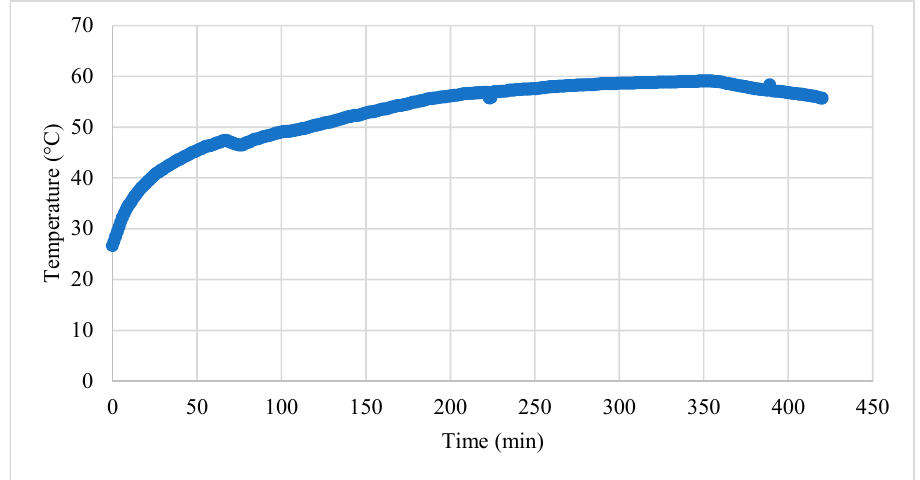
Figure 6. Temperature inside greenhouse solar dryers while drying mango slices.